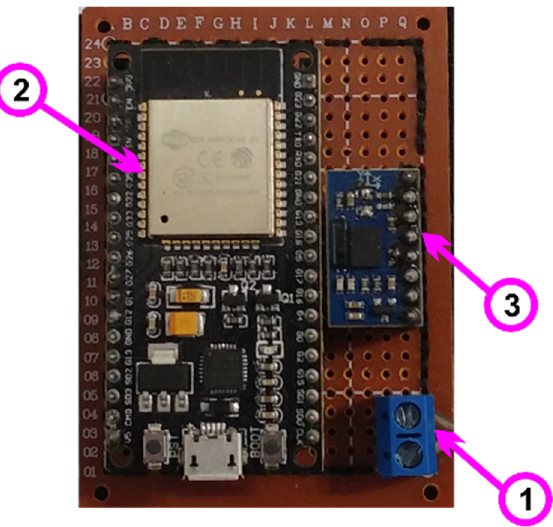
Figure 7. Device for receiving and transmitting data from sensors.